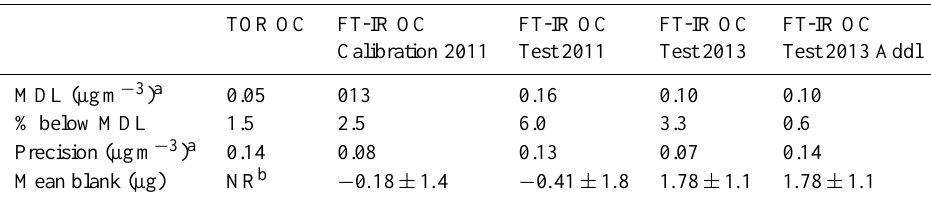
Table 2. MDL and precision for FT-IR OC and TOR OC.